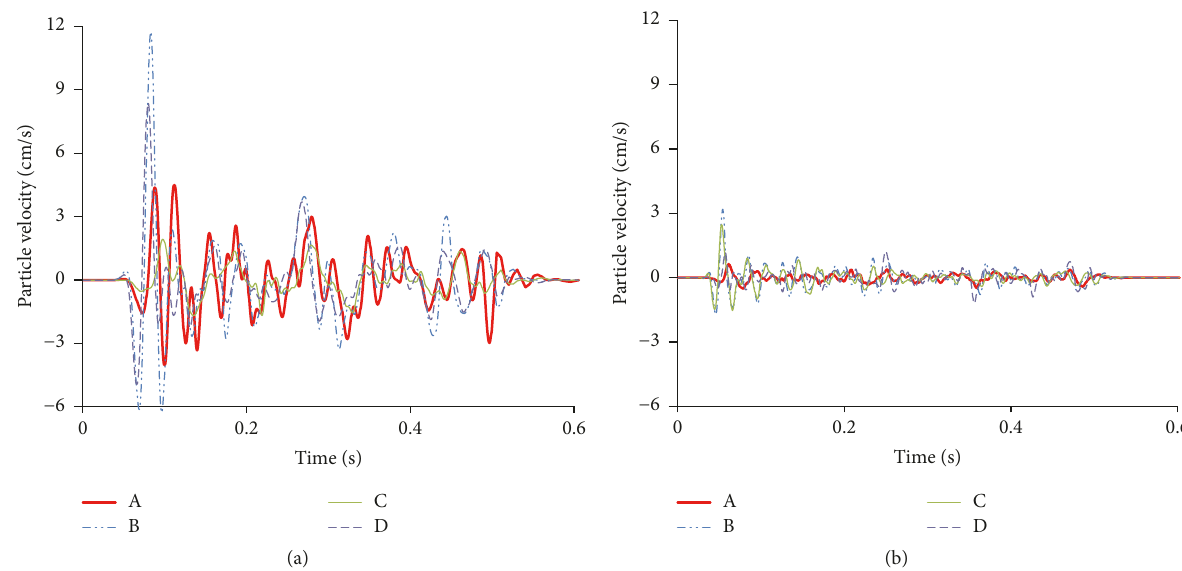
Figure 10: Vertical vibration response on monitoring points induced by full-face blasting (a) and CD method (b).